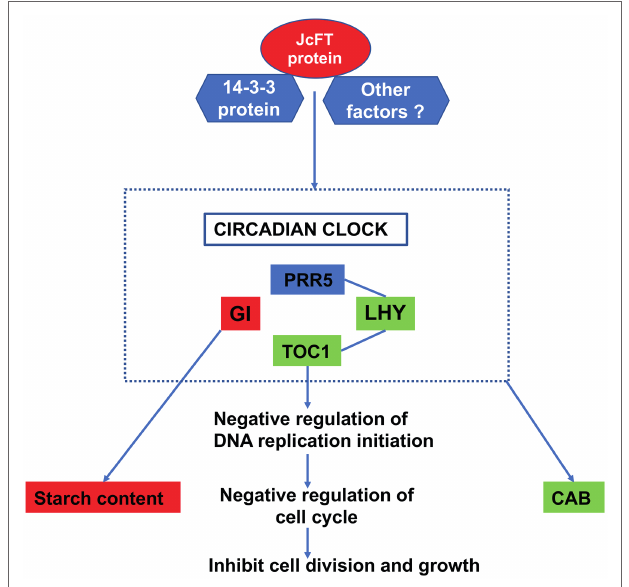
FIGURE 11 | Conceptual model of possible regulation of the circadian clock and DNA replication in stems of JcFT OE plants. Green boxes indicate down- regulation, red ones indicate up-regulation, and the blue one indicates both up- and down-regulation. Arrows indicate order of